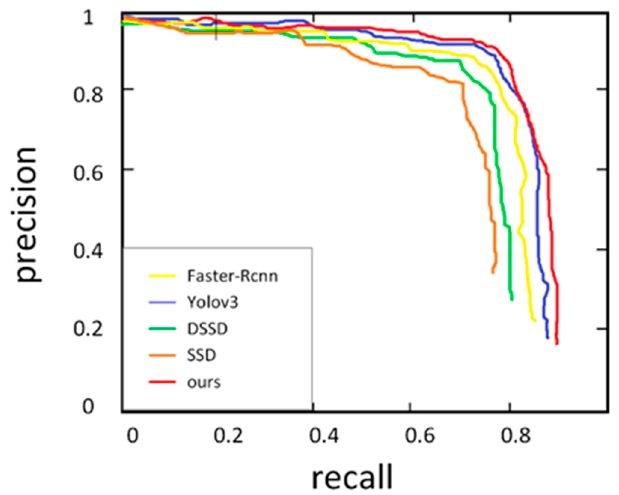
Figure 16. P-R curve, Yellow is the PR curve of Faster-RCNN; purple is the PR curve of YOLOv3; green is the PR curve of DSSD; orange is the PR curve of SSD; red is the PR curve of our algorithm.